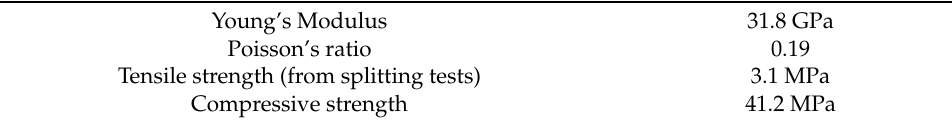
Table 1. Concrete